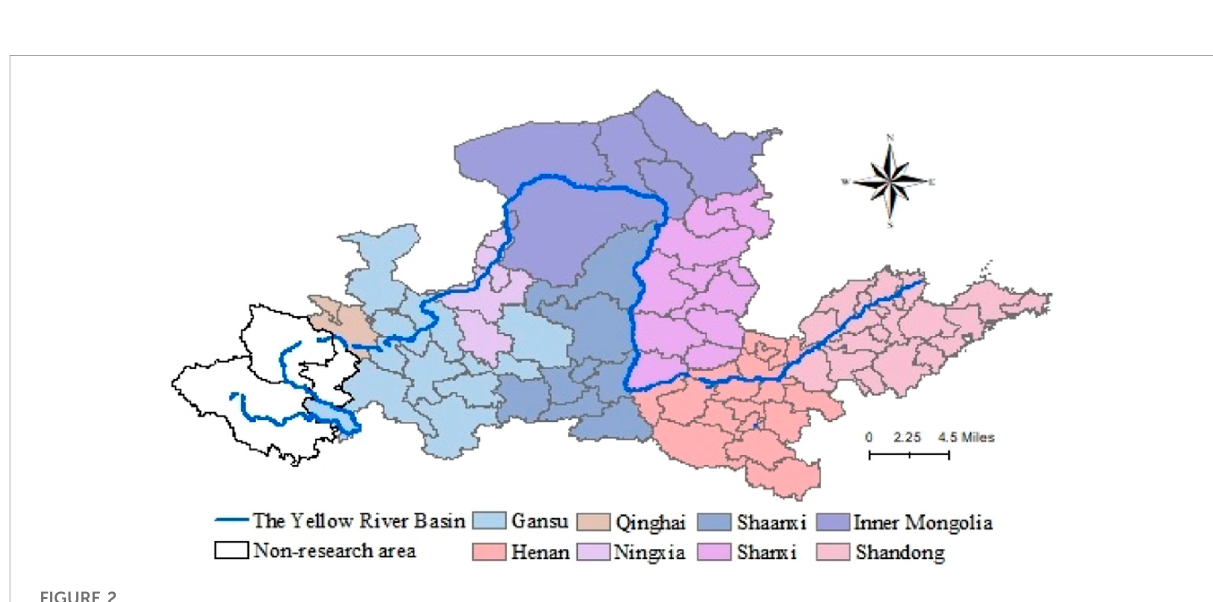
FIGURE 2 Location map of cities (states and leagues) in the Yellow River